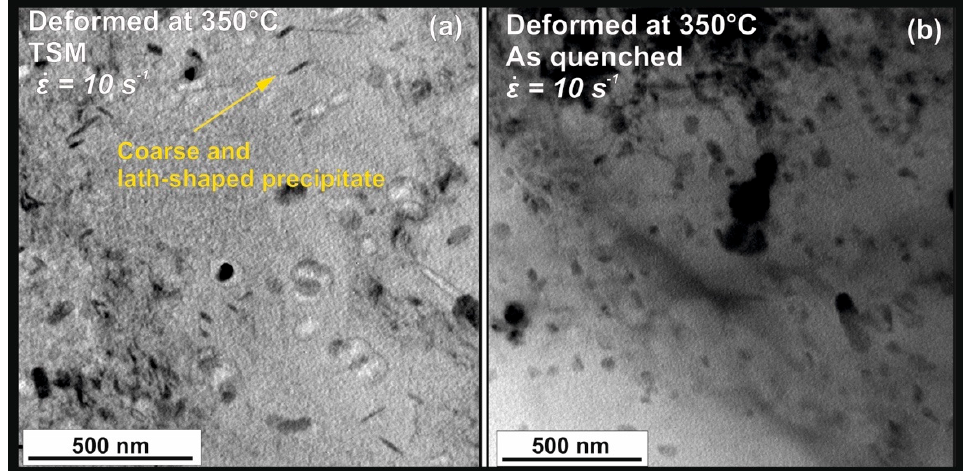
Figure 9. TEM micrograph of the formed microstructure at the deformation temperature of T DT = 350 ◦ C and strain rates of ε = 10 s − 1 for ( a ) TSM condition and ( b ) as-quenched